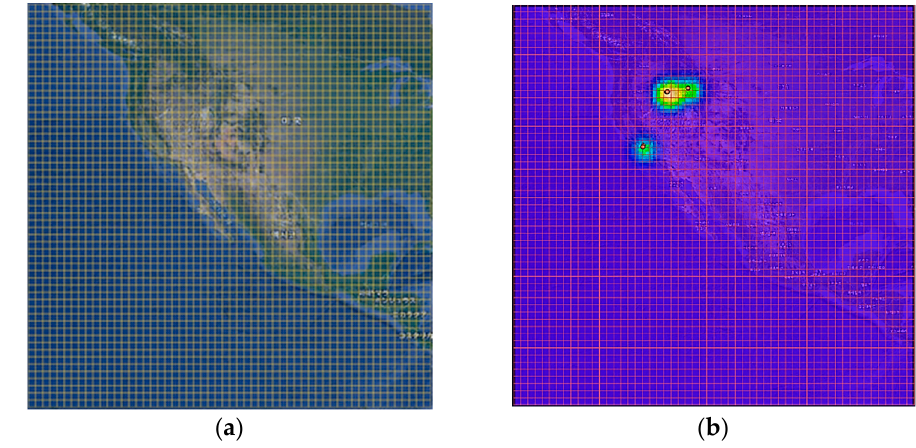
Figure 4. Example of movement density image construction—( a ) grid generation; ( b ) kernel density generation.